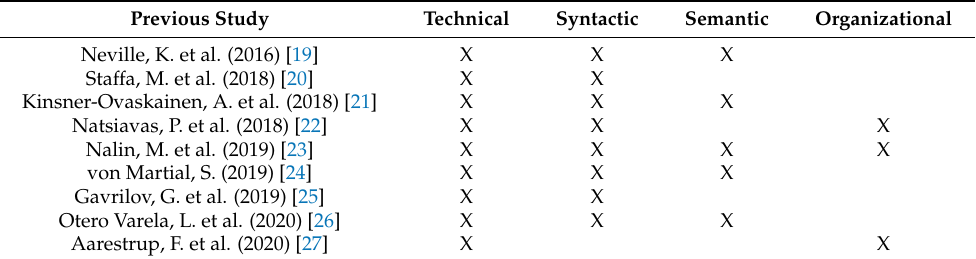
Table 2. Results of the analysis of the related literature using interoperability